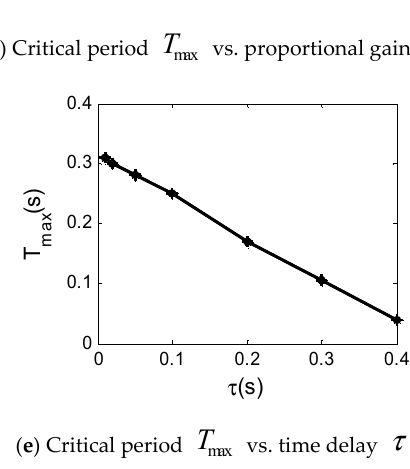
T . Figure 6. Factors influencing the critical period T max